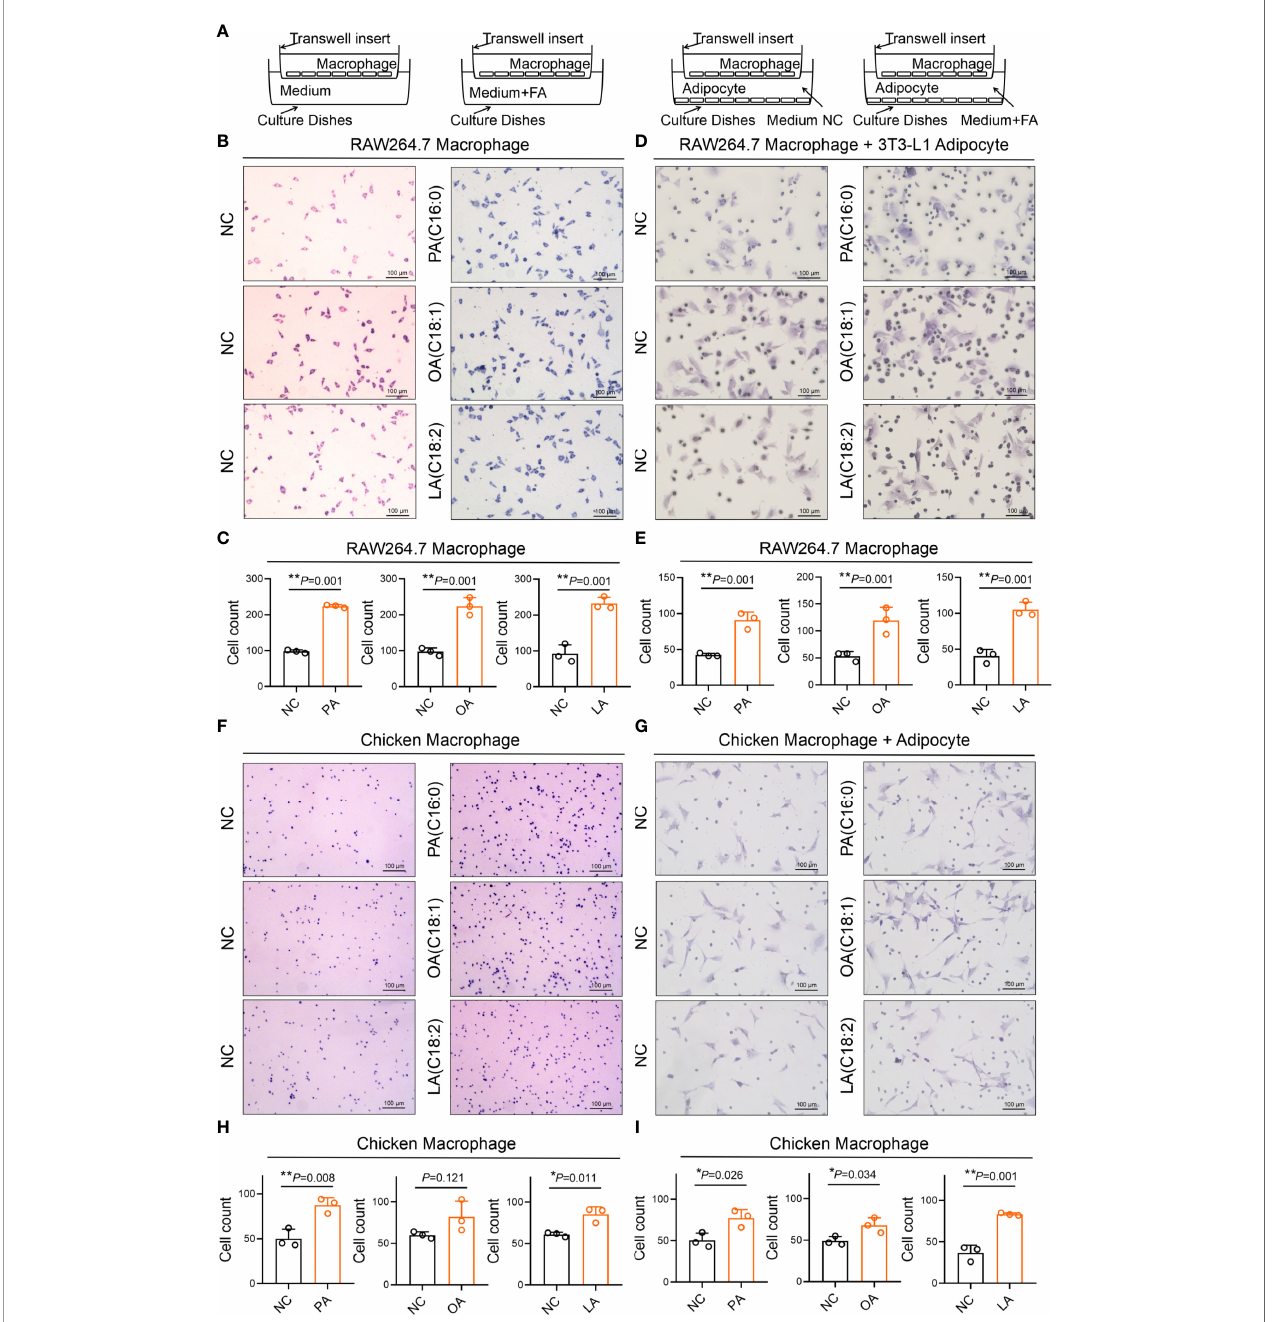
FIGURE 13 | FFA-induced adipocyte recruitment (transwell) of macrophages in chicken and mouse. (A) Schematic diagram of FFA-induced adipocyte recruit macrophage in chicken and mouse; (B, D) FFA-induced 3T3-L1 adipocyte recruit RAW264.7 macrophage; (C, E) FFA-induced 3T3-L1 adipocyte recruit the number of RAW264.7 macrophage in unit area for 24 h; (F, G) FFA-induced chicken adipocyte recruit chicken macrophage; (H, I) FFA-induced chicken adipocyte recruit the number of chicken macrophage in unit area for 24 h. a,b= p